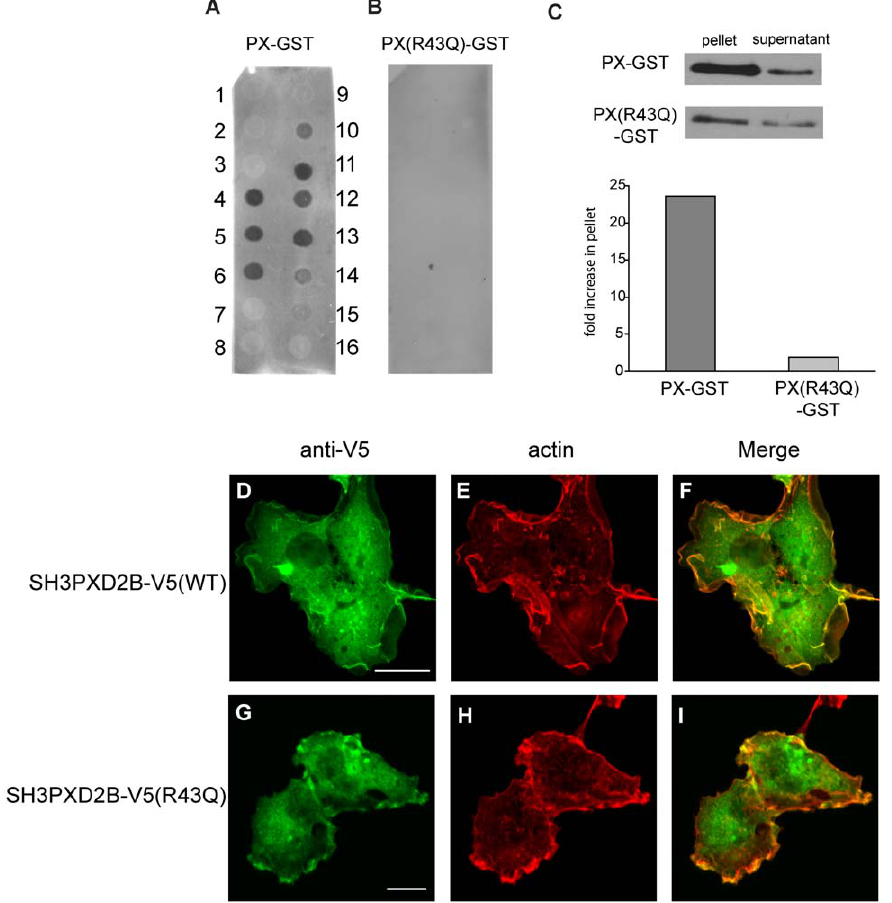
Figure 5. Characterization of the lipid-bindig domain of SH3PXD2B. ( A and B ) The lipid specificity of the PX-domain of SH3PXD2B was tested in protein-lipid overlay assay experiments using a recombinant GST fusion protein that contained the first 130 amino acid region of SH3PXD2B ( panel A , PX-GST) or its derivative containing the R43Q substitution within the PX-domain (panel B , PX(R43Q). Layout of the PIP strip was the following: 1 . Lysophosphatidic acid 2 . Lyso-phosphatidylcholine 3 . Phosphatidylinositol (PtdIns) 4 . PtdIns(3)P 5 . PtdIns(4)P 6 . PtdIns(5)P 7 . Phosphatidylethanolamine 8 . Phosphatidylcholine 9 . Sphingosine 1-phosphate 10 . PtdIns (3,4)P 2 11 . PtdIns(3,5)P 2 12 . PtdIns(4,5)P 2 13 . PtdIns(3,4,5)P 3 14 . Phosphatidic acid 15 . Phosphatidylserine 16 . Blank. ( C ) Liposomes containing Phosphatidylcholine and PtdIns(3)P were mixed with recombinant PX-GST or PX(R43Q)-GST and centrifuged at at 80000 g for 20 minutes. Pellet and supernatant were separated, boiled and